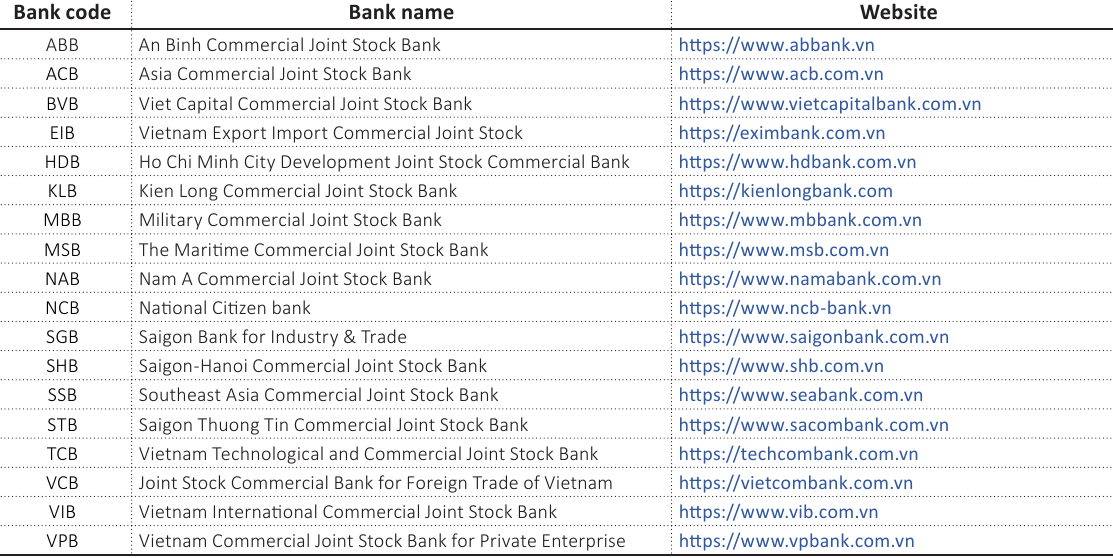
Table 1. The information of banks in the dataset Bank code